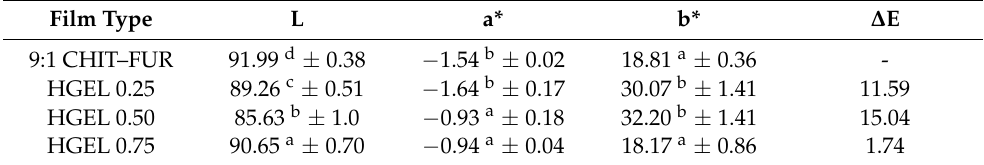
Table 2. Colour properties of CHIT–FUR films and their blends with